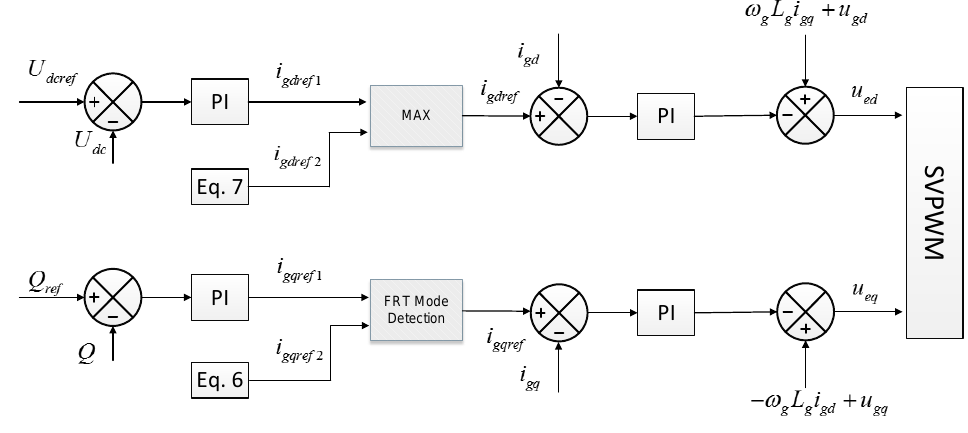
Figure 6. Control blocks of modified GSC.